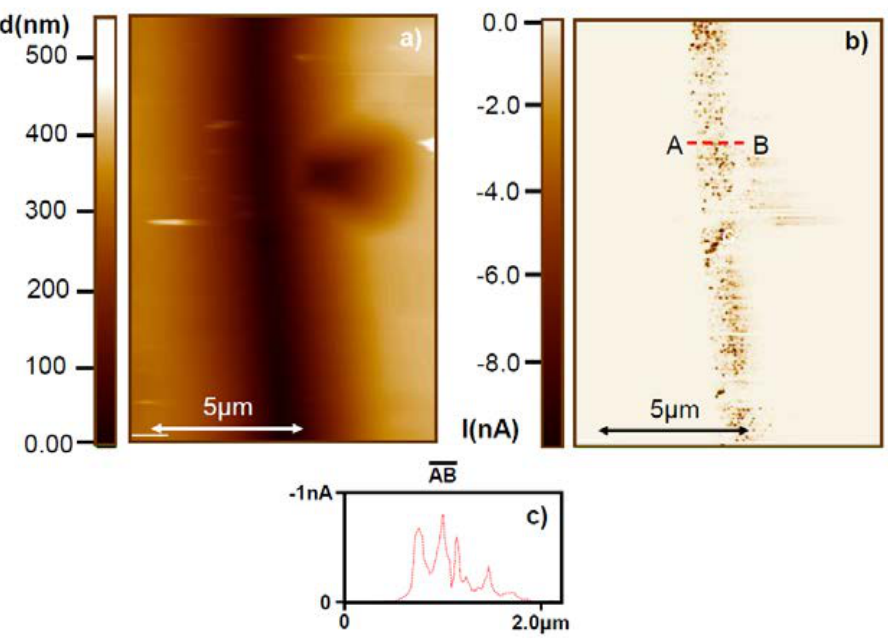
Figure 41. AFM ( a ) and LCAFM ( b ) investigations of the reduced and pre-etched SrTiO 3 bicrystal shows correlations between positions of the etch pits (along the boundary) and bands of the conducting filaments. This finding in fact confirms the hypothesis about easy reductions of the core of dislocations. Cross-section ( c ), obtained perpendicular to the boundary, presents that the broad conducting channels are accumulated along the boundary.